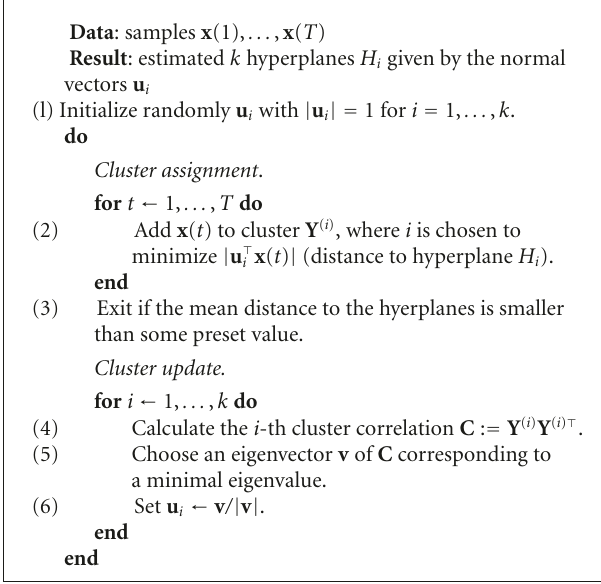
Algorithm 3: k -hyperplane clustering